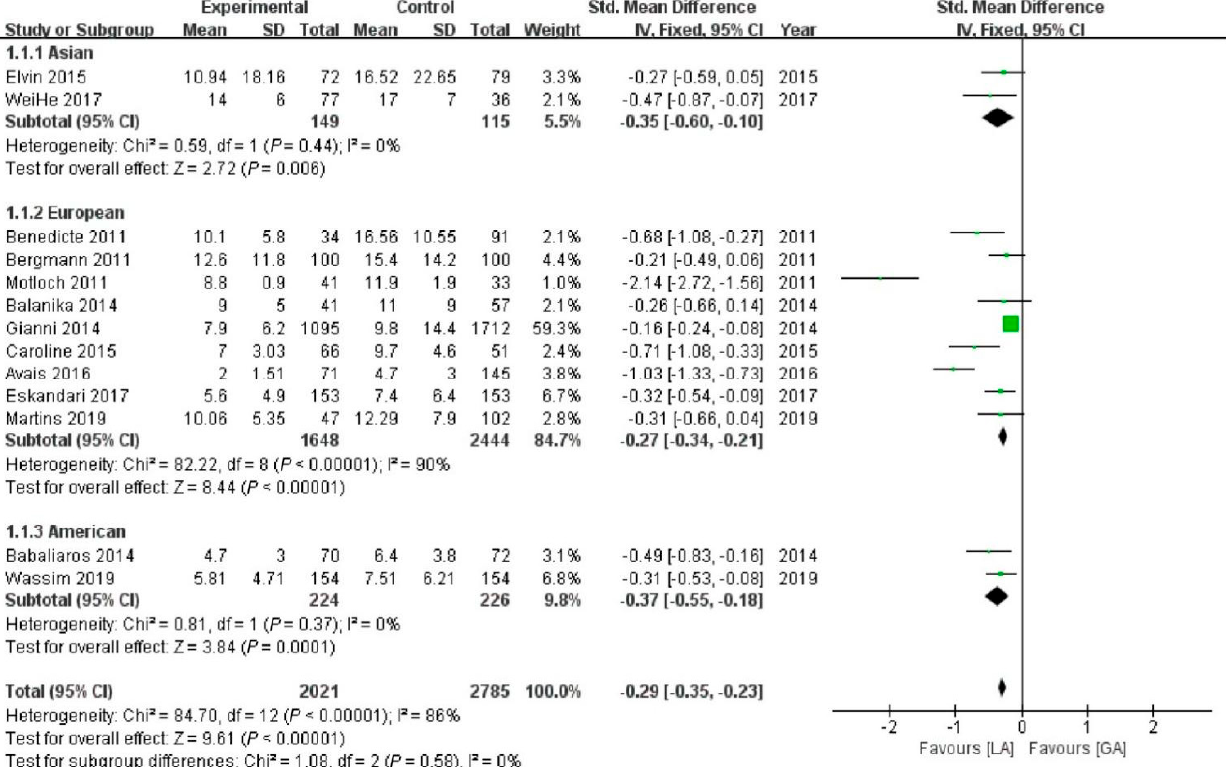
Figure 7. Subgroup analysis of race in length of stay. Green symbols: continuous data; blue symbols: dichotomous data; black symbols: other type data.